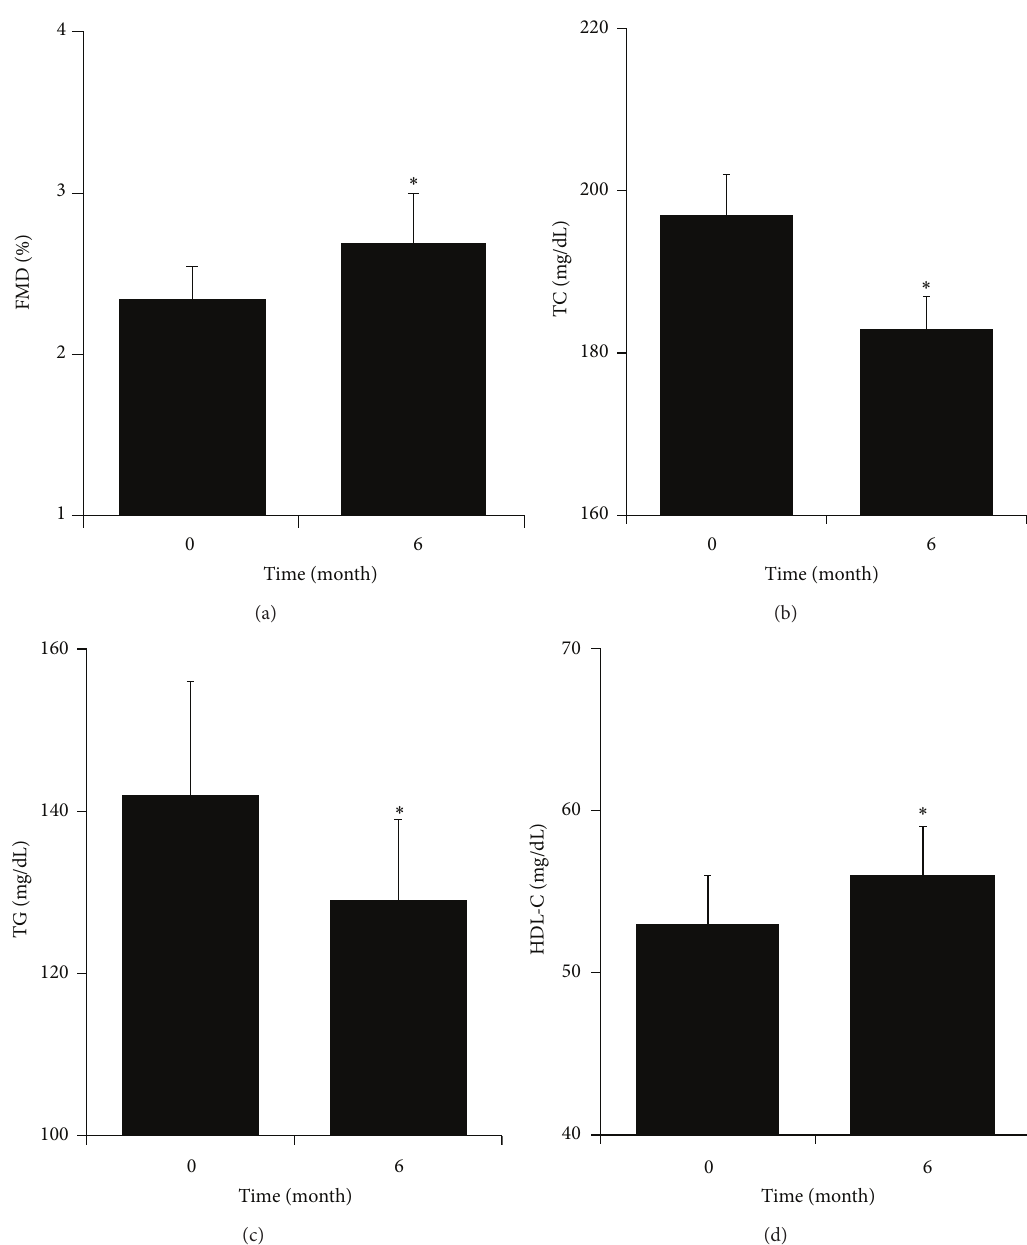
Figure 1: Temporal changes in flow-mediated dilation (a) and lipid profiles ((b)–(d)). FMD: flow-mediated dilation; TC: total cholesterol; TG: triglycerides; and HDL-C: high density lipoprotein cholesterol. ∗ Significant difference from baseline.